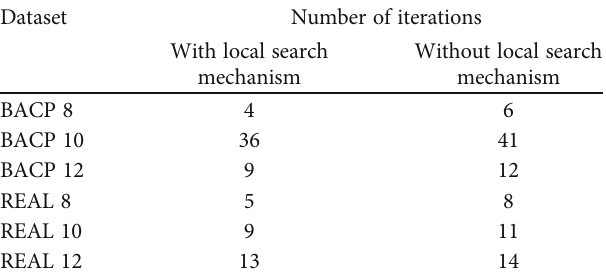
T ABLE 3: Comparison of number of iterations required with local search mechanism and without local search mechanism.